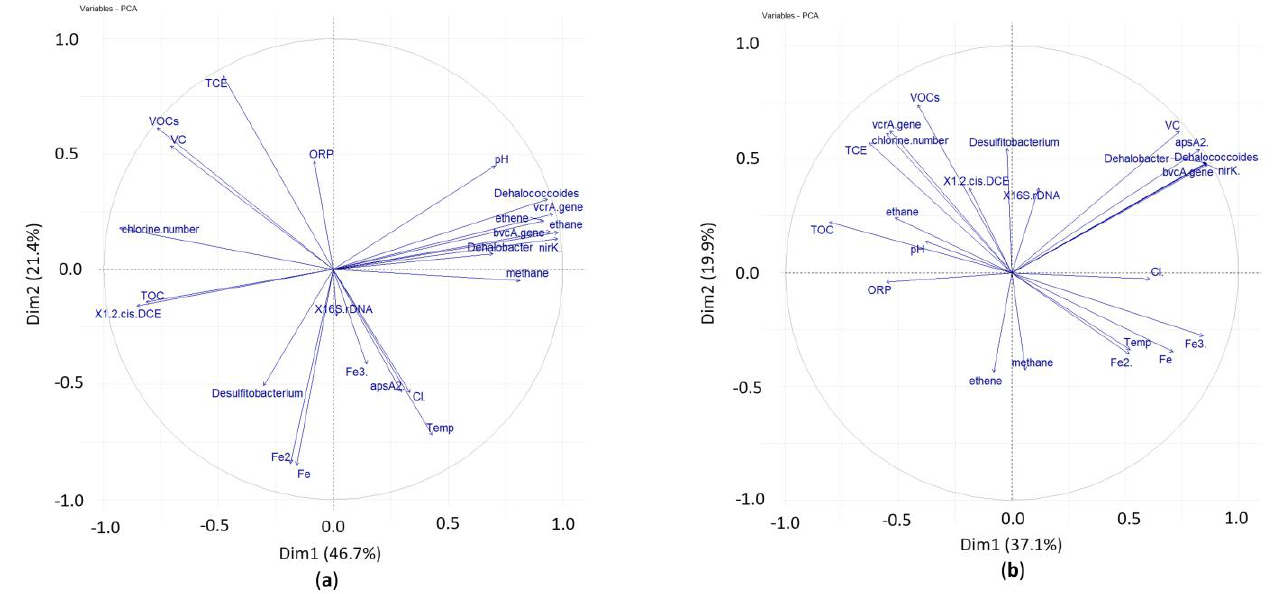
Figure 9. Principal component analysis of the qPCR, chemical and physical parameters, concentra- tions of iron, chlorides, chlorinated ethenes, ethene, and ethane. Refer to the text for the abbrevia- tions used in test set-up ( a ) with whey and ( b ) without